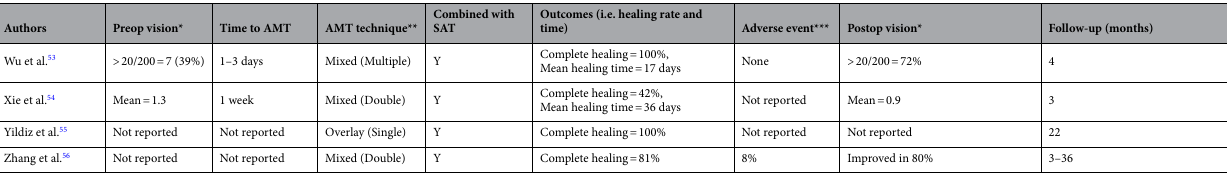
Table 2. Summary of all clinical studies (excluding RCTs) evaluating the use of amniotic membrane transplantion (AMT) for infectious keratitis. BK bacterial keratitis, FK fungal keratitis, VK viral keratitis, AK acanthamoeba keratitis, MK mixed keratitis, NSK non-specified keratitis, SAT standard antimicrobial treatment, NRCS non-randomized controlled studies, CF counting fingers, HM hand movement, PL perception of light. $ Severity of the corneal ulcer is presented either in maximum linear diameter (mm), in area (mm 2 ) or in percentage of total cornea (%). *Vision is presented in either Snellen vision or logMAR vision. **AMT technique is categorized by the type of grafting (inlay as graft vs. overlay as patch vs. mixed inlay/overlay) and number of layers (single layer vs. double layer vs. multiple layers). ***Adverse event was defined as uncontrolled/worsening infectious keratitis requiring tectonic keratoplasty or